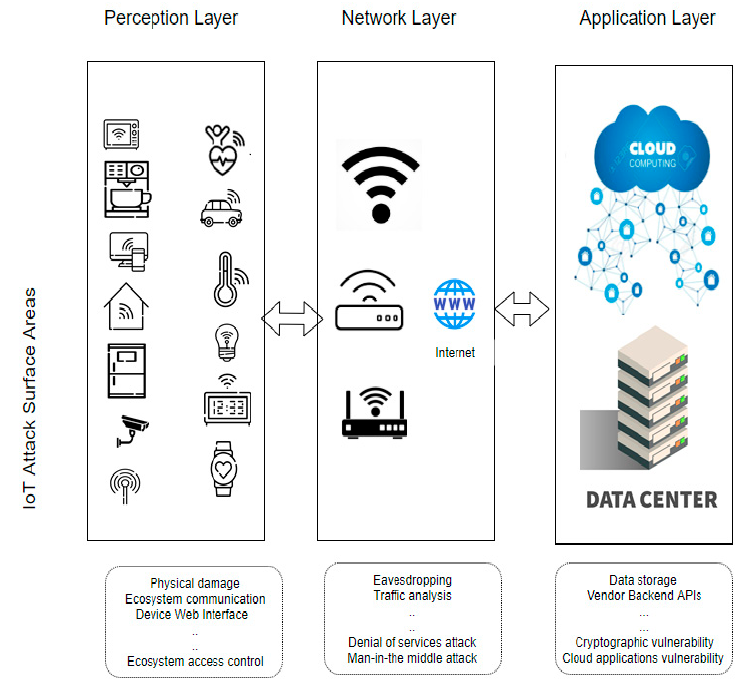
Figure 1. Internet of Things (IoT) architecture and layer attacks.